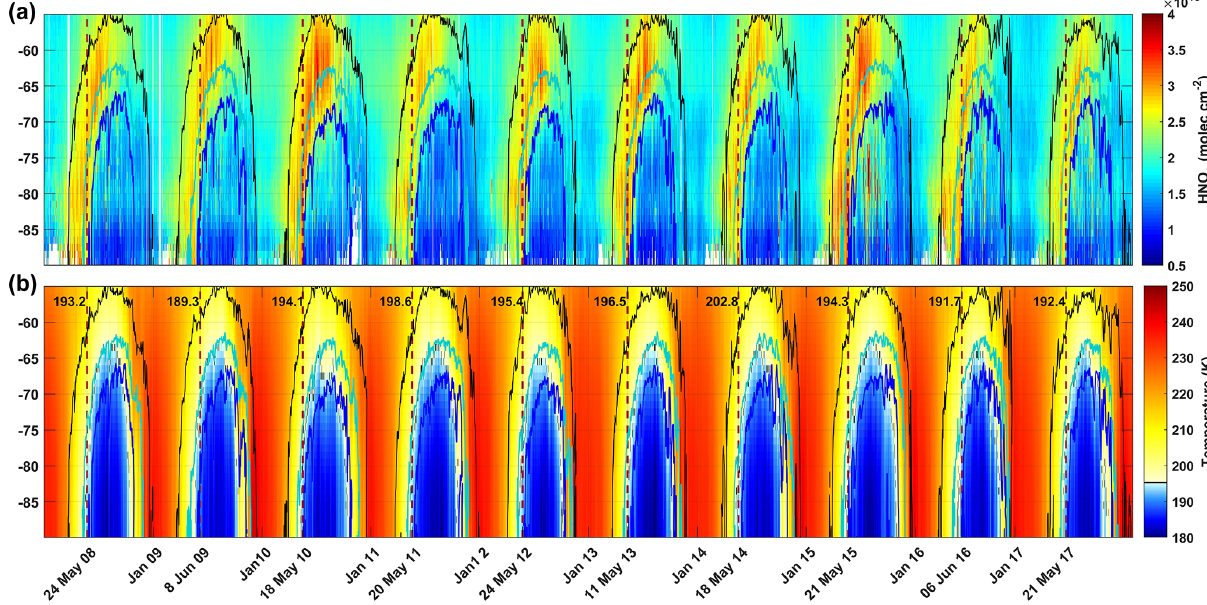
Figure 6. Zonally averaged distributions of (a) HNO 3 total columns (in molec . cm − 2 ) from IASI and (b) temperatures at 50hPa from ERA- Interim (in K). The geographical latitude range is from 55–90 ◦ S and the isocontours are PVs of − 5 (black), − 8 (cyan) and − 10 (blue) ( × 10 − 5 Km 2 kg − 1 s − 1 at 530K). The vertical dashed red lines correspond to the second derivative minima each year in the area delimited by a − 10 × 10 − 5 Km 2 kg − 1 s − 1 PV